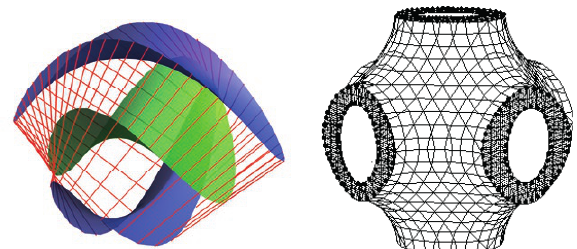
Figure 30. Left : View of a hyperbolic molecular bilayer, showing the (green) interface, which traces the surface running through the centre of the bilayer between the chain ends and parallel interfaces (blue) traced out by the head-groups in both monolayers. Right: Global view of one possible hyperbolic bilayer geometry – the